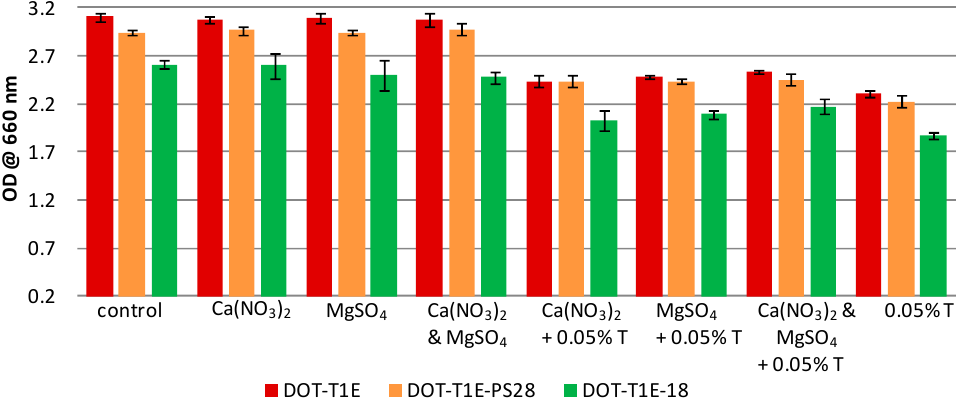
Figure 2. Turbidity at OD 660 nm of P. putida strains after 8 h incubation in LB medium supplemented with or without 7 mM magnesium and 3 mM calcium in the absence and presence of 0.05% ( v / v ) toluene. Colours represent different strains: the wild-type DOT-T1E (red), the mutant DOT-T1E-PS28 (yellow), and the mutant DOT-T1E-18 (green). Bars of the means of four replicates and error bars are standard deviations.